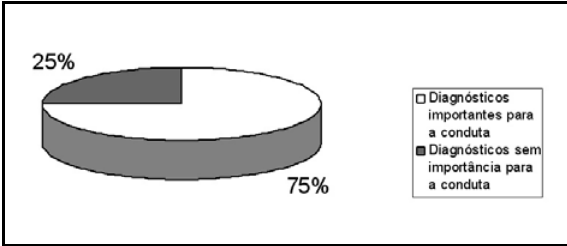
Figura 3 – Importância do diagnóstico per-operatório para a conduta neurocirúrgica imediata excluindo biópsias estereotáxicas (total de 63